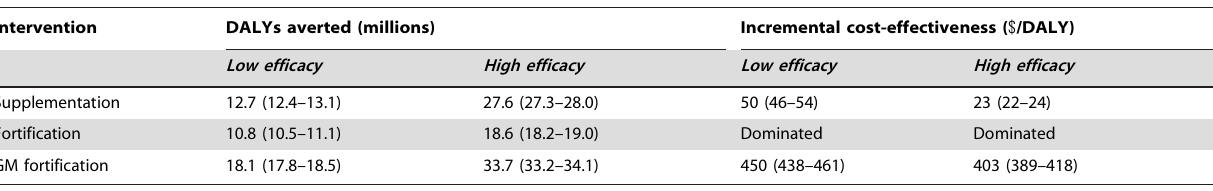
Table 4. DALYs averted for each intervention over 20-year time horizon.